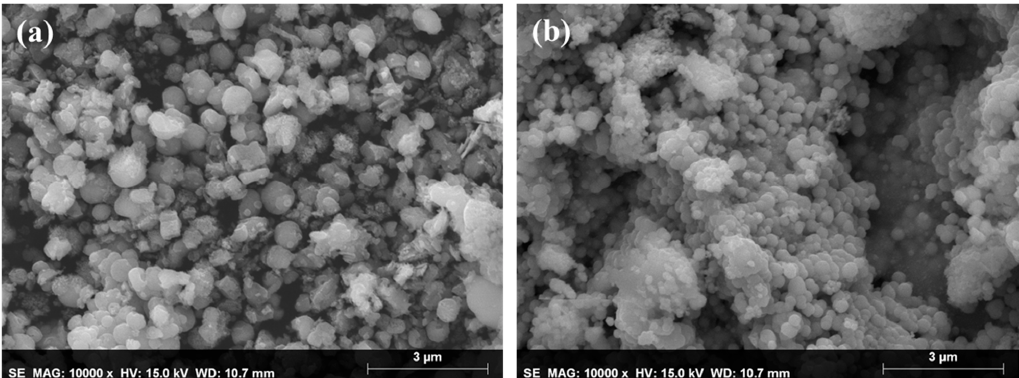
Figure 3. Scanning electron microscopy (SEM) images of as-synthesized pure ZnCo 2 O 4 ( a ) and ZnCo 2 O 4 /SnO 2 -20% ( b ) samples. The center of each picture corresponds to the place where the energy